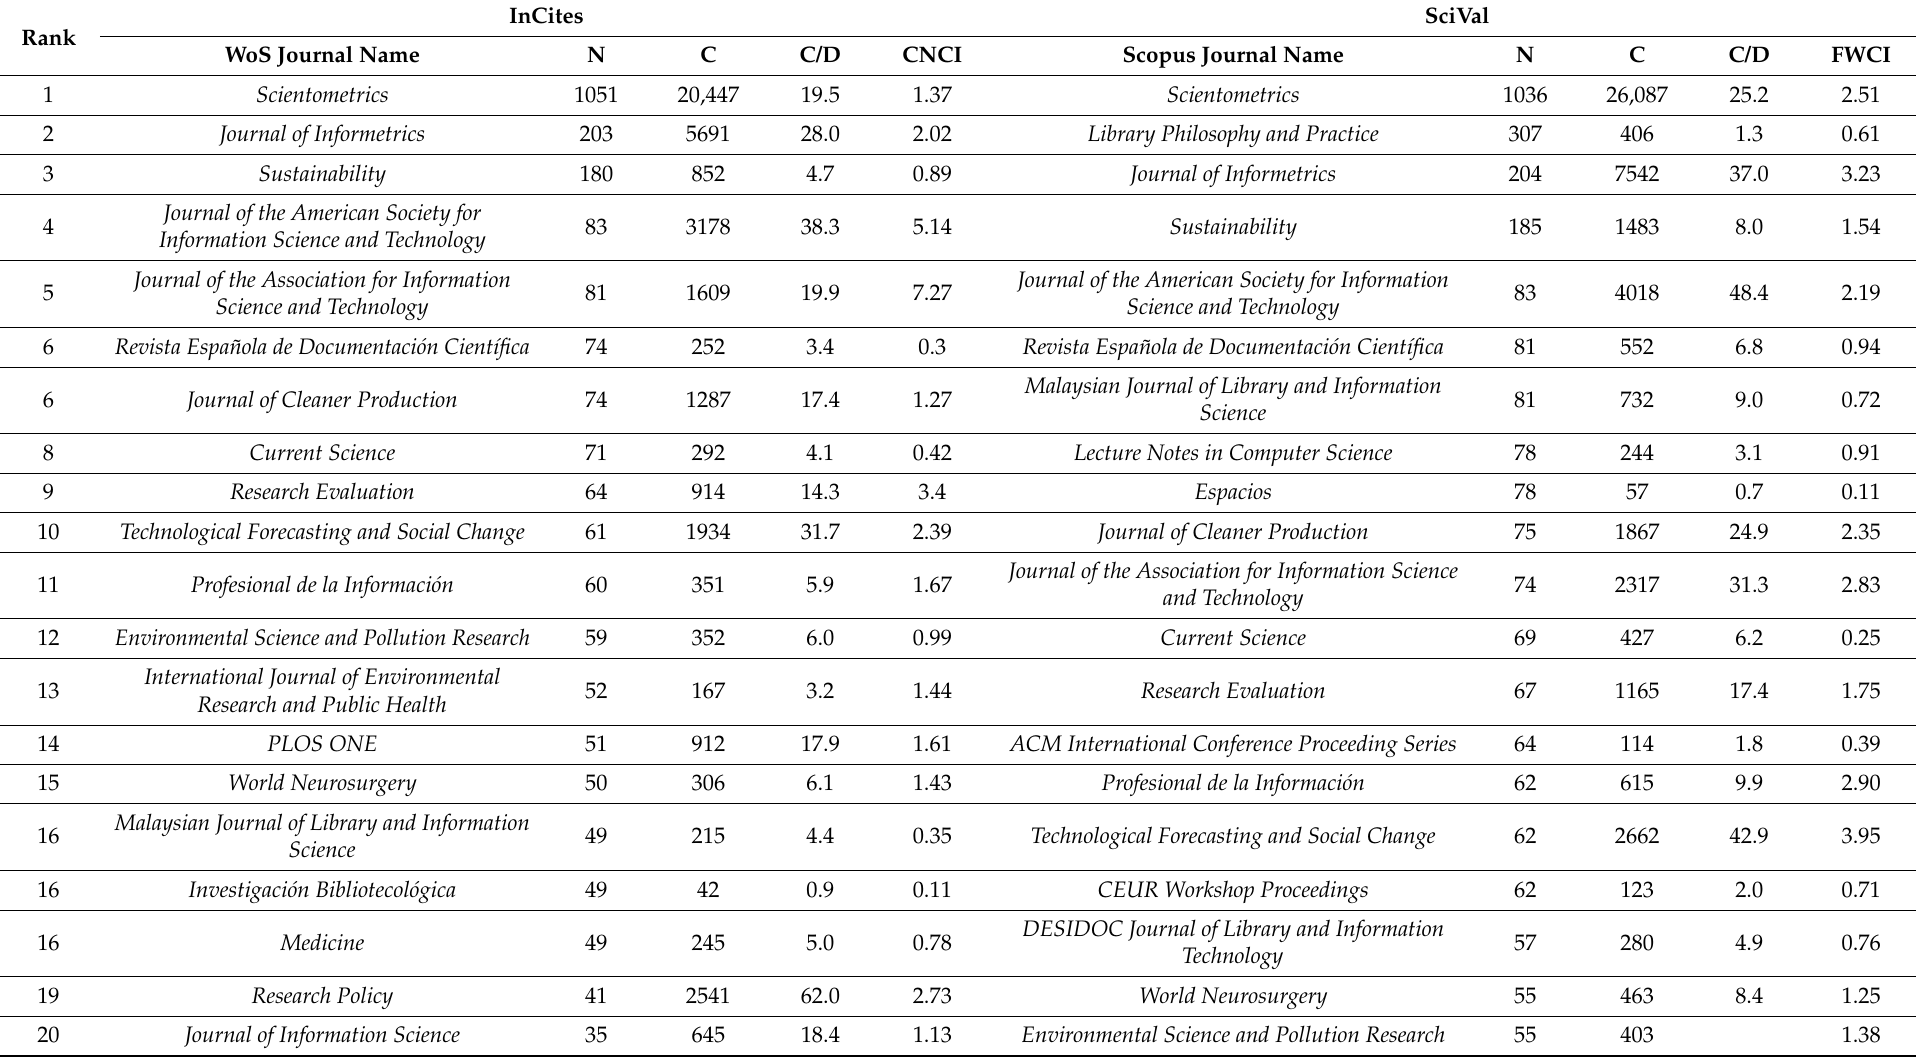
Table 10. CNCI (Category Normalized Citation Impact) from InCites and FWCI (Field-Weighted Citation Impact) from